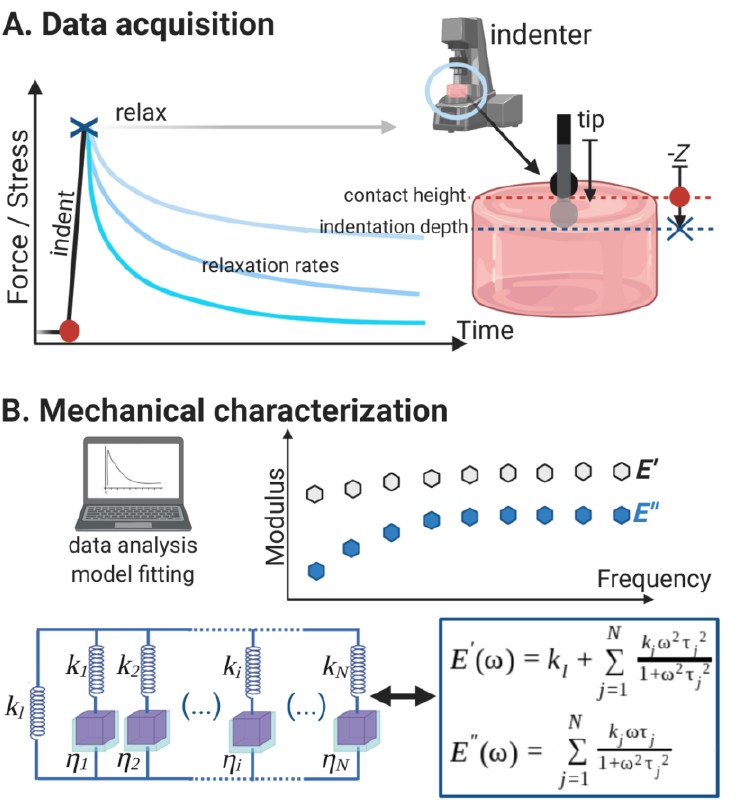
Figure 1. Diagram (not to scale) of the method employed here to study with great precision the mechanical properties and dynamic behavior of polyacrylamide (PAM) hydrogels used in mechanobiology assays. A ) Relaxation test performed with a microindenter; it collects all the information necessary to analyze the hydrogels mechanically. The bead is typically 50 µm in diameter and the gel ~200 µm thick. B ) The data collected from the relaxation test is adjusted using a generalized Maxwell model (GMM) with the appropriate relaxation times τ i that then allows to obtain the corresponding k i and η i . The long term stiffness k l (or k ∞ ) is also determined from the model fitting. Finally, the dynamic storage ( E’ ) and loss ( E” ) moduli that describe the soft material were calculated, assuming a linear viscoelastic behavior. This complete characteri- zation is more accurate than a microindentation and calculation of the elastic (Young’s) modulus.